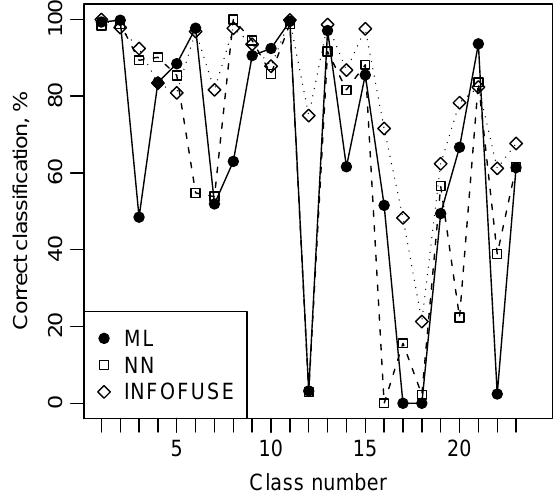
Figure 1: Class test accuracy for the WV-2+TSX Texture+Optical Texture+DSM data fusion and classification using the ML, NN, and INFOFUSE Subscenes of a classification map (INFOFUSE; WV-2 multispec- tral+TSX Texture+Optical Texture+DSM) are presented in Fig- ures 2, 3, and 4.